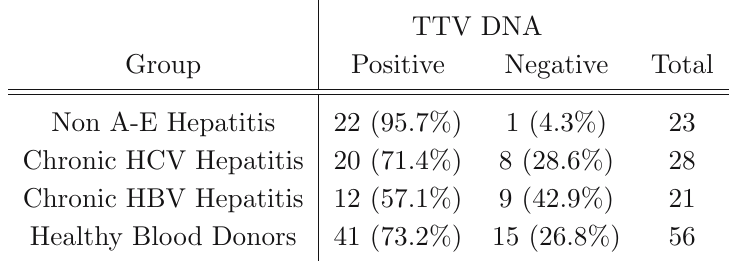
Table 4 Combined detection rates of TTV DNA in study